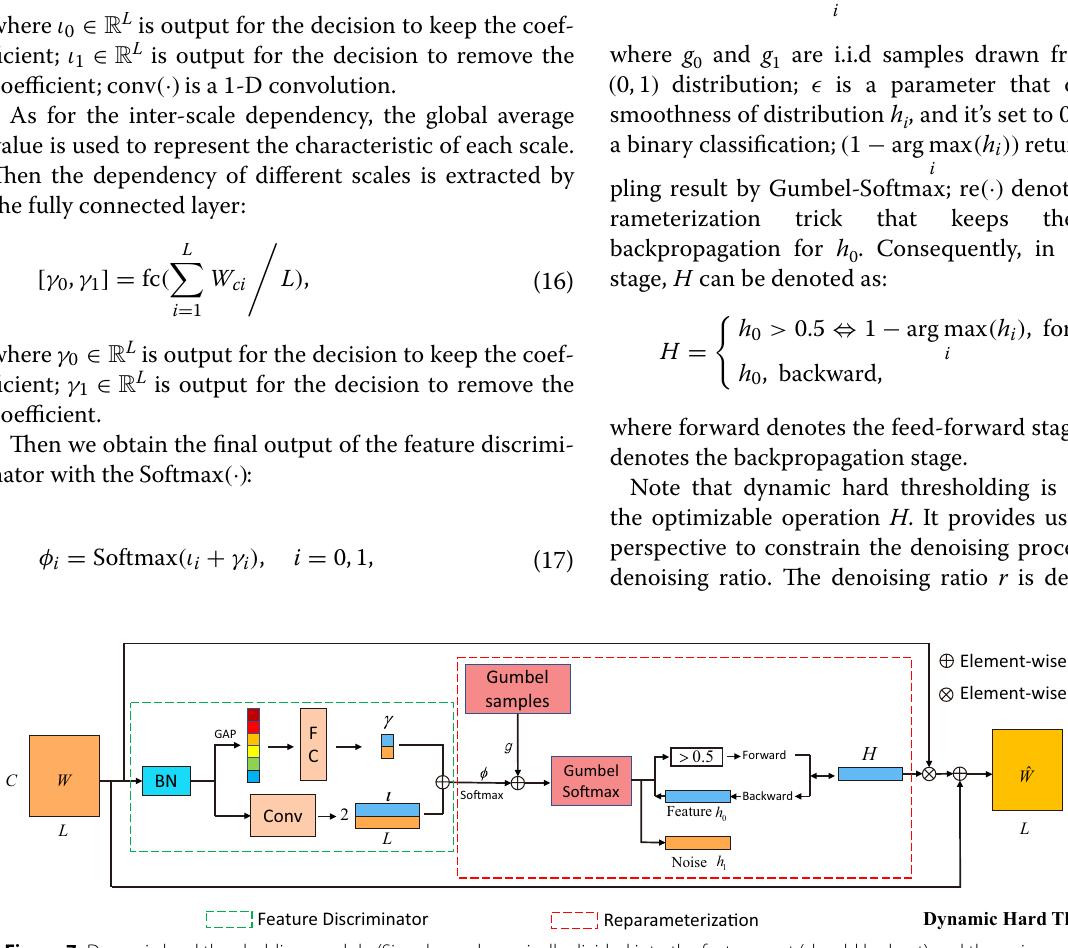
Figure 7 Dynamic hard thresholding module (Signals are dynamically divided into the feature part (should be kept) and the noise part (should be removed) with the feature discriminator. Gumbel-Softmax reparameterization is a trick module that converts feature decisions into an optimizable hard thresholding